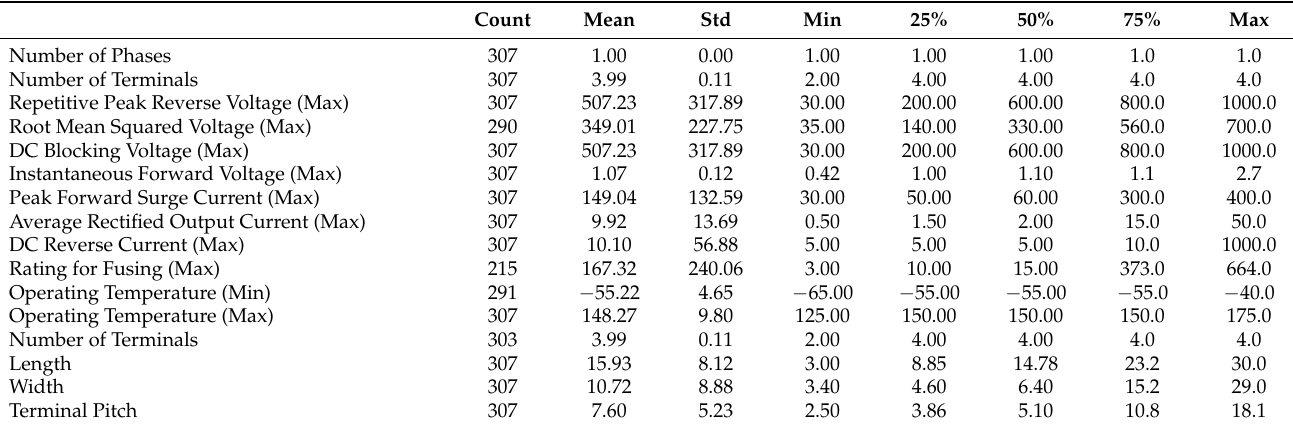
Table 5. Statistics for the features of bridge rectifier